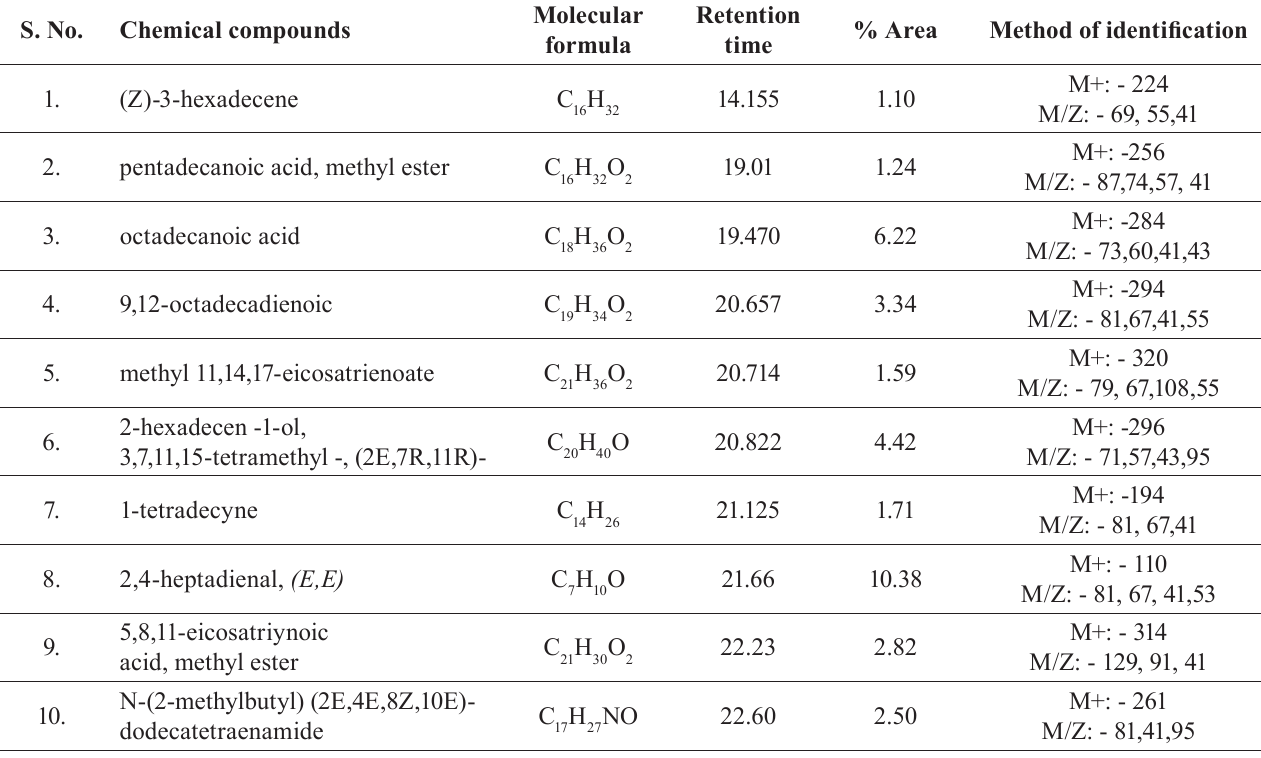
TABLE II - Chemical composition of methanolic extract of whole plant of A. uliginosa S.